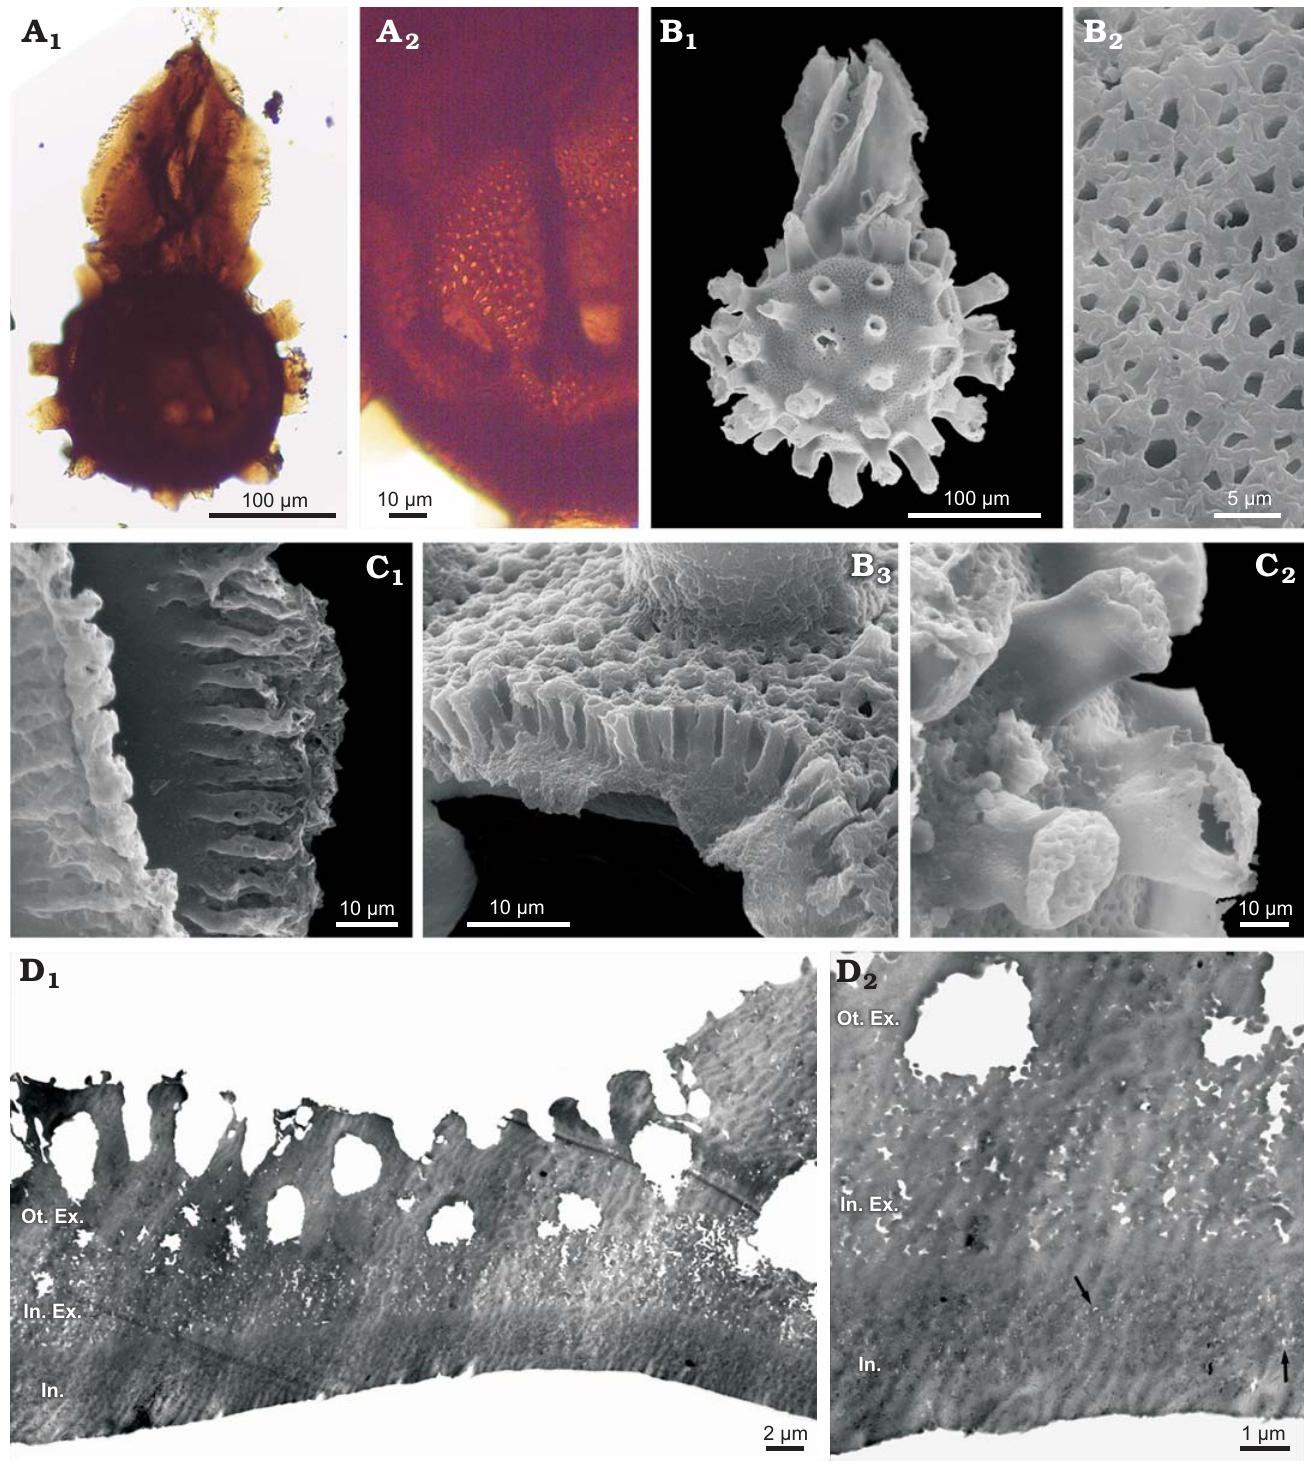
Fig. 3. Megaspores of the water fern Arcellites disciformis (Miner, 1935) Ellis and Tschudy, 1964; Cenomanian, town of Tres Lagos, Argentina. A . MPM- Pb-18907a (N40/1), general view under light microscope (A 1 ), a detail of the pitted pattern (A 2 ). B . MPM-Pb-18907 SEM stub 1, general view